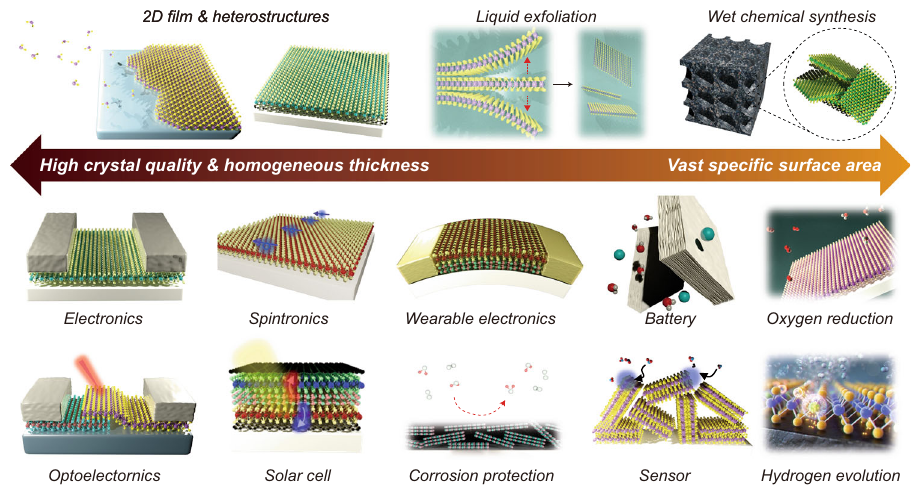
Fig. 1 Speci fi c target-oriented techniques for the mass production of 2D materials. 2D fi lms and heterostructures require high crystal quality and homogeneous thickness for applications such as electronics and spintronics, whereas high-porosity powders with vast speci fi c surface area can be used in contexts such as catalysts and energy